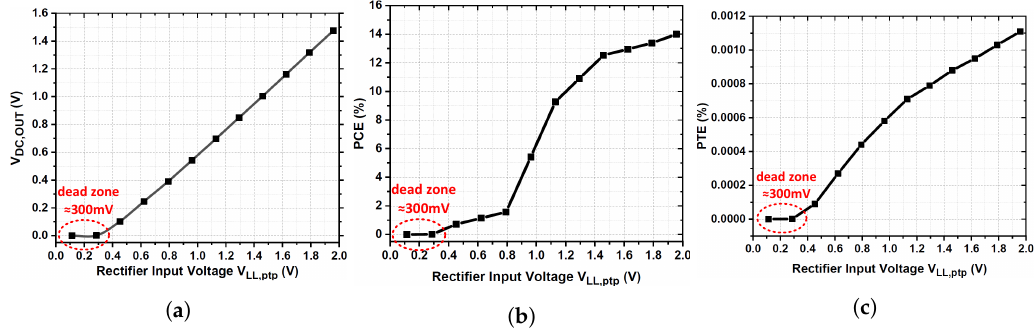
Figure 6. Characterization results of the rectifier shown in Figure 4. ( a ) V DC , OUT , ( b ) power conversion efficiency (PCE), and ( c ) power transfer efficiency (PTE) of the rectifier with respect to V LL , ptp the peak-to-peak amplitude of the input voltage of the